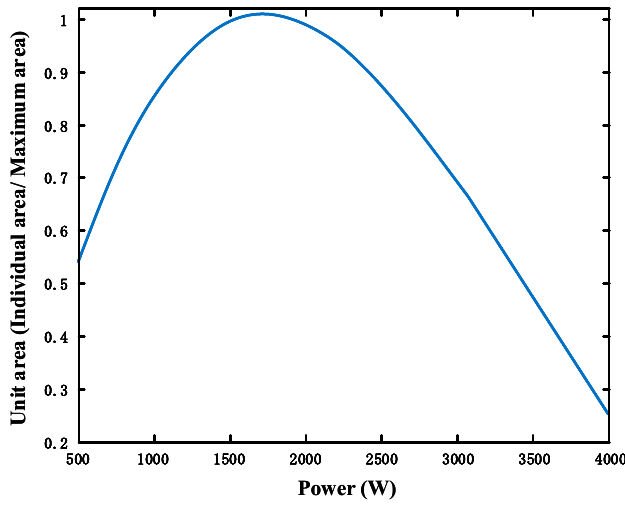
Figure 8. The area of rectangles for different CHP heat output power.